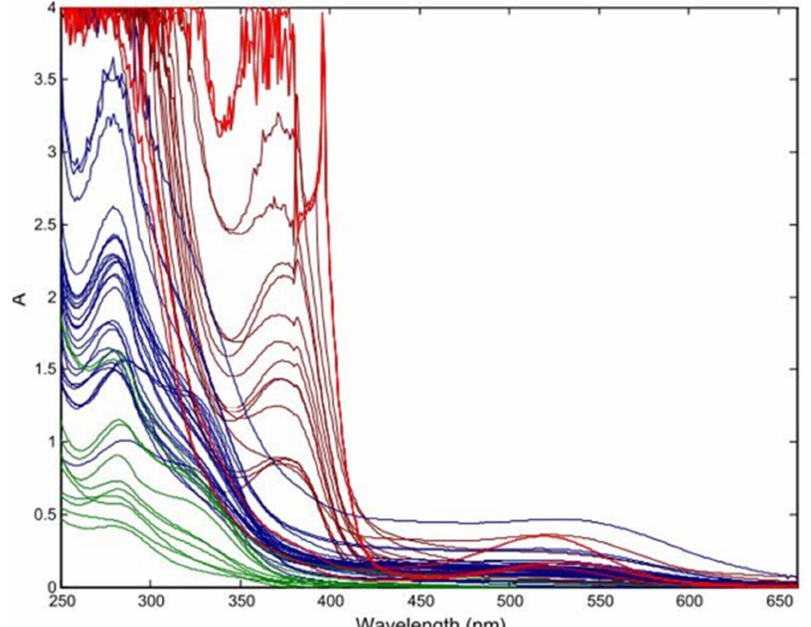
Figure 2. Spectral profile of different fruit juice samples analysed using a UV–VIS spectroscopy-based method. Red lines for authentic lab-prepared pomegranate juices (PA), ginger lines for commercial pomegranate juices, blue line for commercial grape juices and green lines for commercial apple